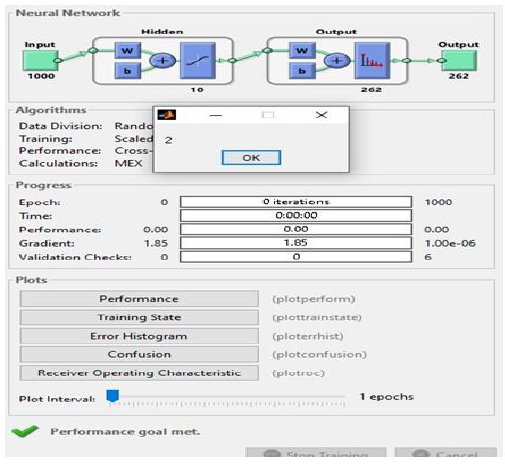
Fig 5. MATLAB output showing conditions The output is displayed on the hardware through a liquid crystal display. The LCD keeps running a loop by displaying the readings of the vital parameters one after the other. Also, it displays the condition of the infant whether abnormal or normal.